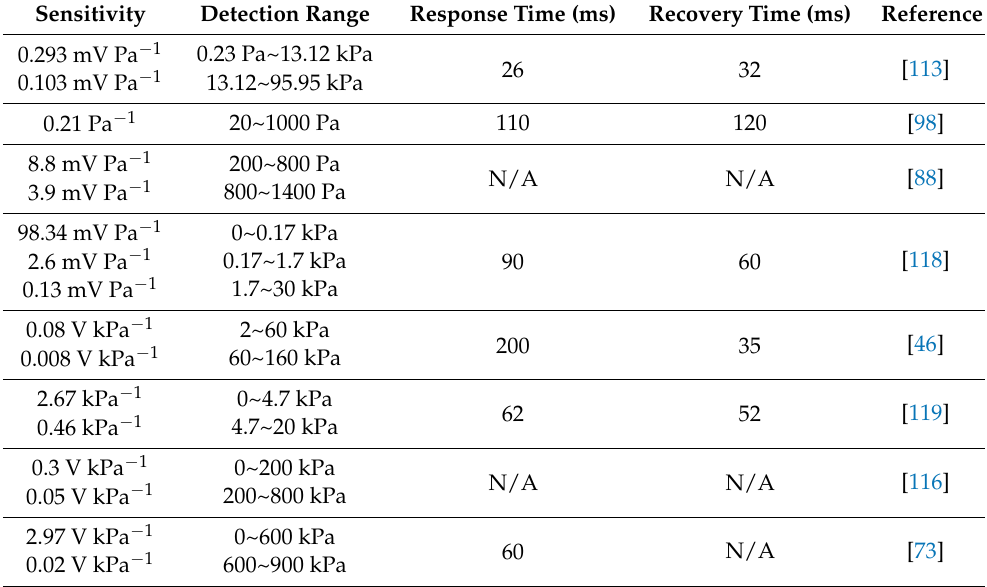
Table 2. The performance of TENG sensors for pressure. Sensitivity Detection